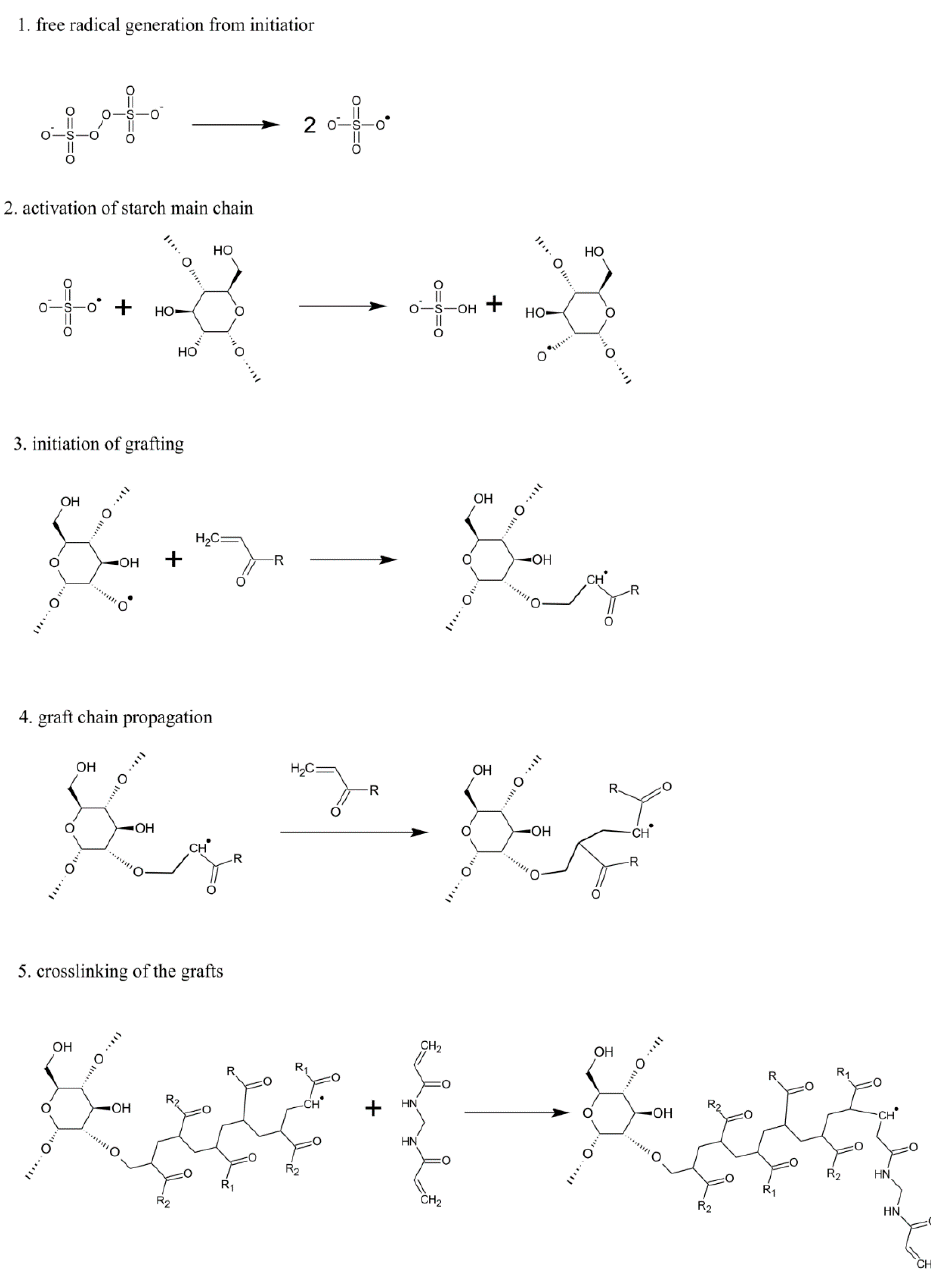
Figure 2. Possible mechanism of the grafting/crosslinking reaction of starch, acrylate monomers and MBA crosslinker.